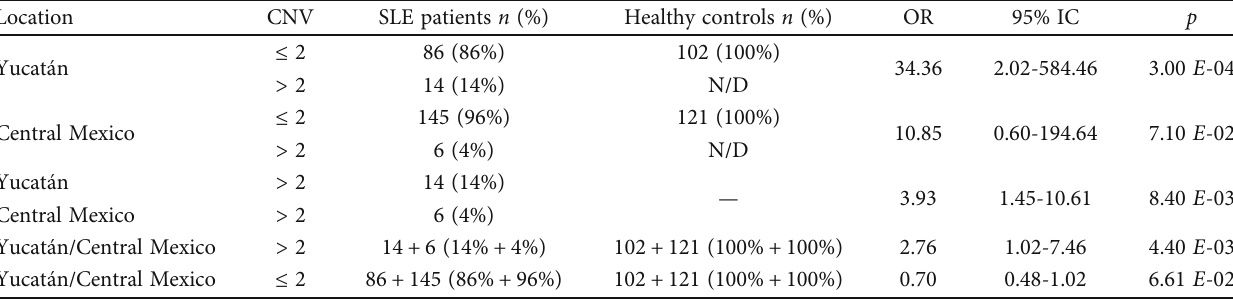
Table 1: Association analysis of CNV of the TLR7 in SLE patients and healthy controls from Yucatán and Central Mexico.